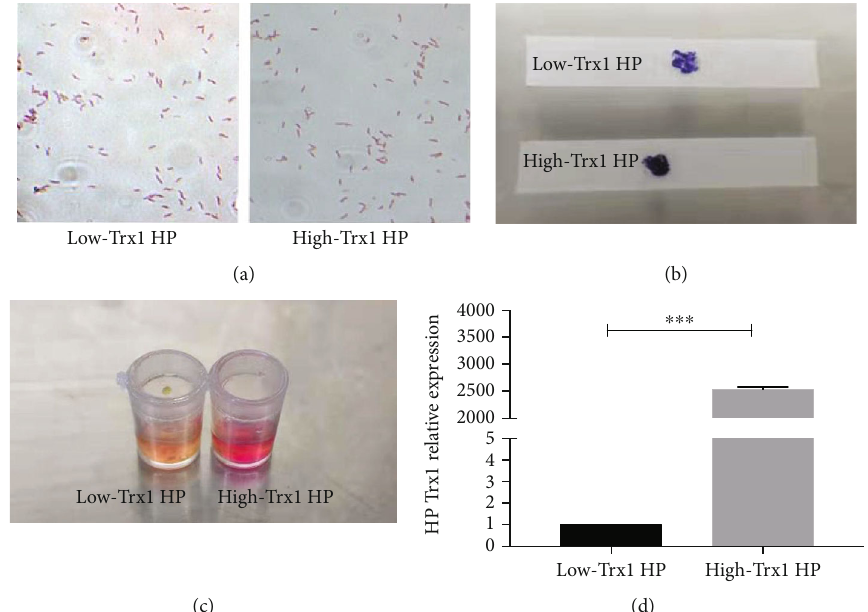
Figure 1: Identi fi cation of the low-Trx1 and high-Trx1 HP bacteria strain. (a) Gram staining with low-Trx1 HP and high-Trx1 HP was observed under an oil microscope. (b, c) Detection of oxidase and urease assay with the low-Trx1 HP and high-Trx1 HP. (d) The Trx1 expression of low-Trx1 HP and high-Trx1 HP was analyzed by real-time PCR. Note: low-Trx1 HP means HP with low Trx1 expression, and high-Trx1 HP means HP with high Trx1 expression, ∗∗∗ P < 0 : 001